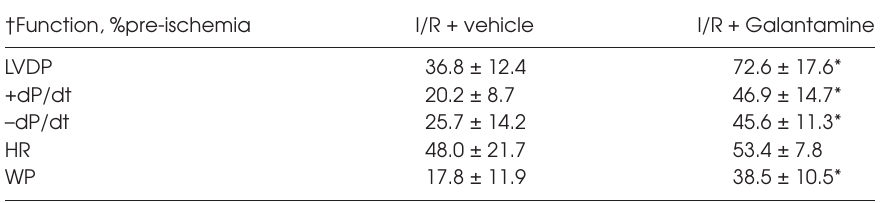
Table 1. Left ventricular pressure measurements of isolated rat hearts recorded after ischemia during the reperfusion period.